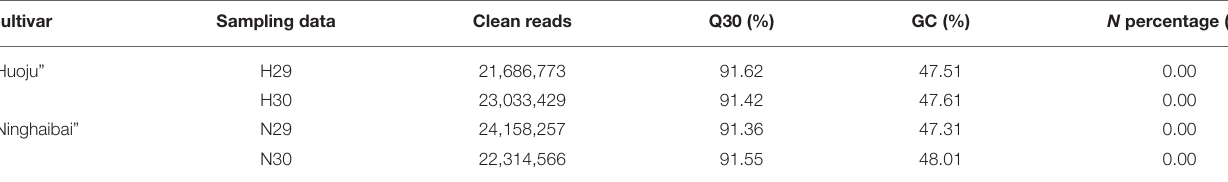
TABLE 2 | Summary of Illumina transcriptome sequencing for loquat rachis under cold stress. Cultivar